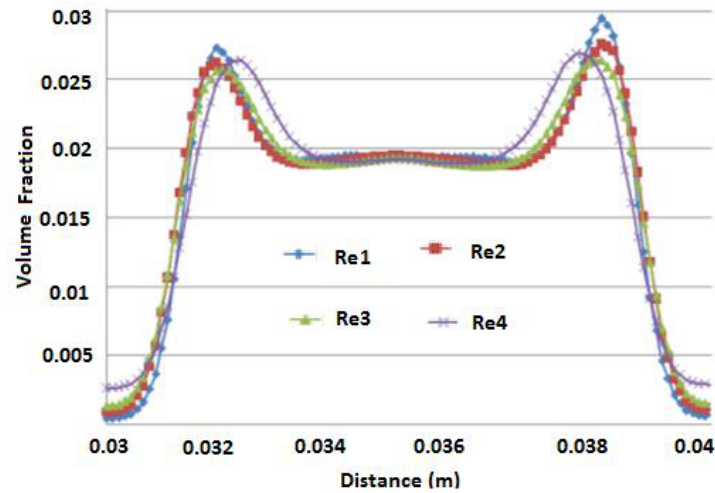
Figure 3. Variation of solid phase volume fraction (for W 9 slurry) for different slurry velocities at constant RPM of inner wall along plane